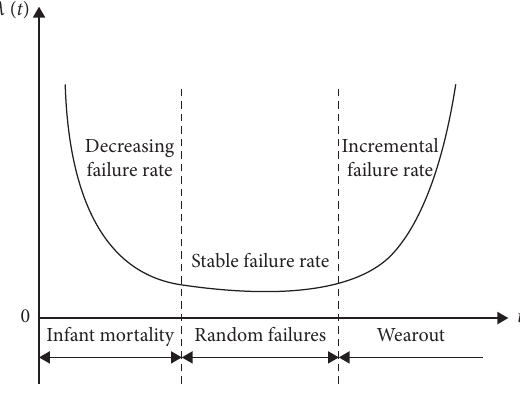
Figure 1: Bathtub curve of failure